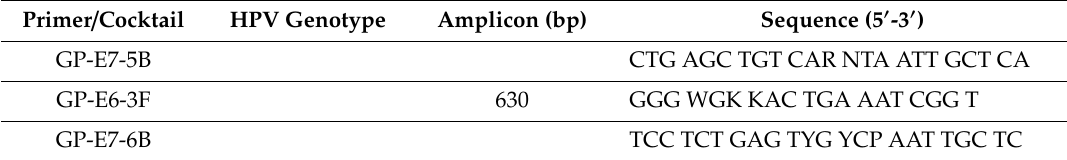
Table 1. Sequences of type-specific nested PCR